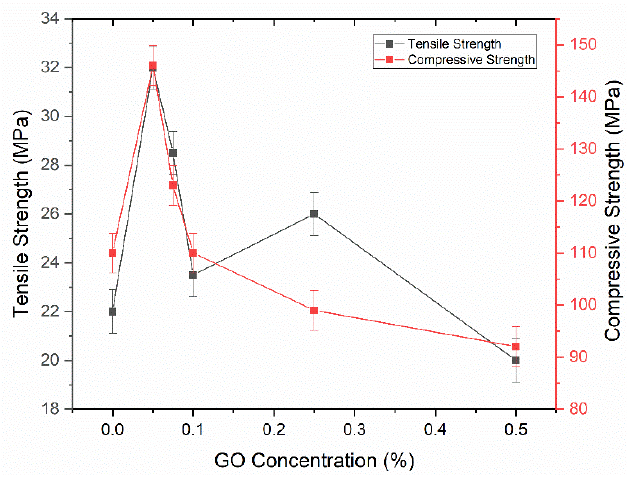
Figure 12. Tensile and compressive strength of GO ‐ based nanocomposites with varying GO concentrations.